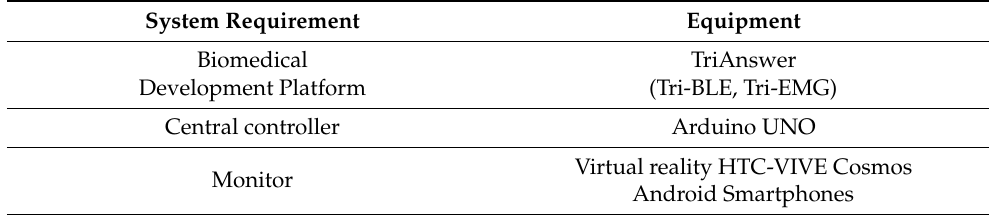
Table 2. Equipment Table 2. Equipment specifications.